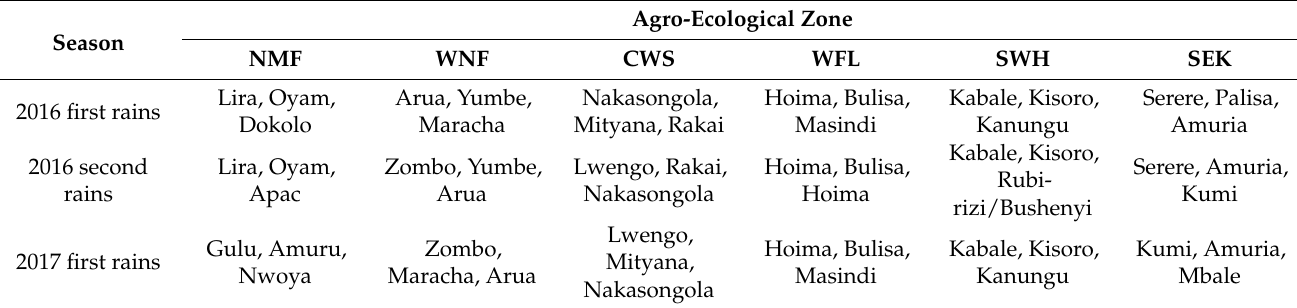
Table 1. Districts sampled in different agro-ecological zones during 2016 and 2017 rains in Uganda.